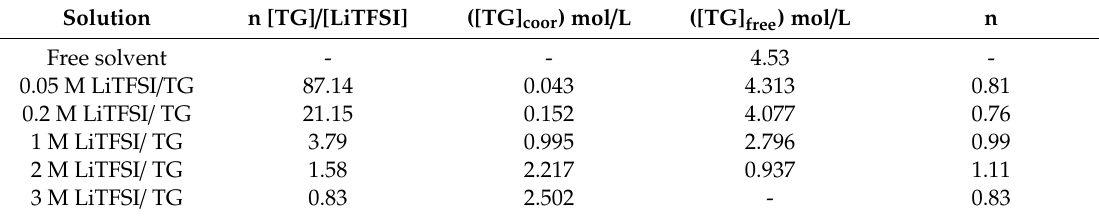
Table 1. Solution properties analyzed from Raman spectra. 106